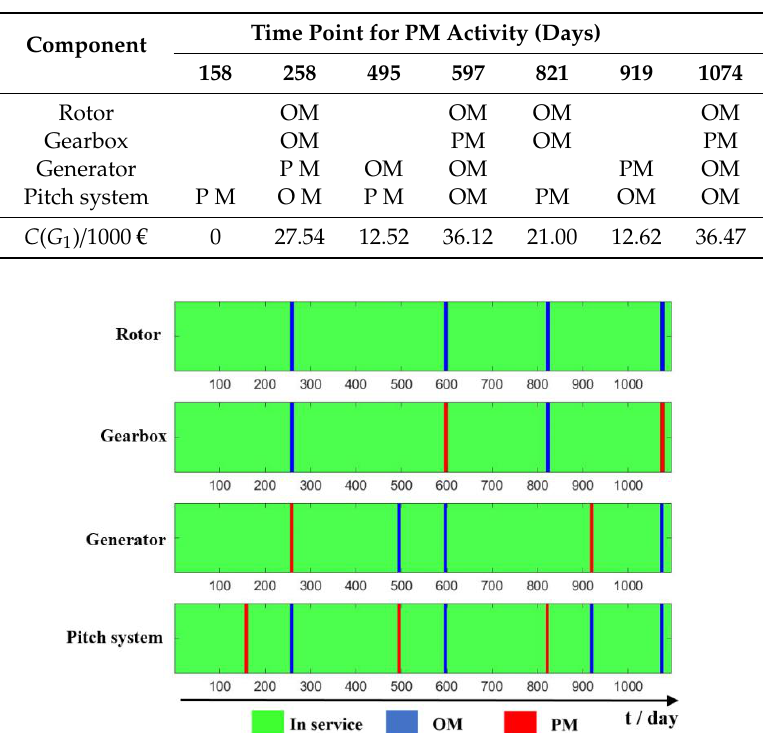
Table 8. The maintenance schedule and cost savings in the first year. OM: opportunistic maintenance, PM: preventative maintenance.